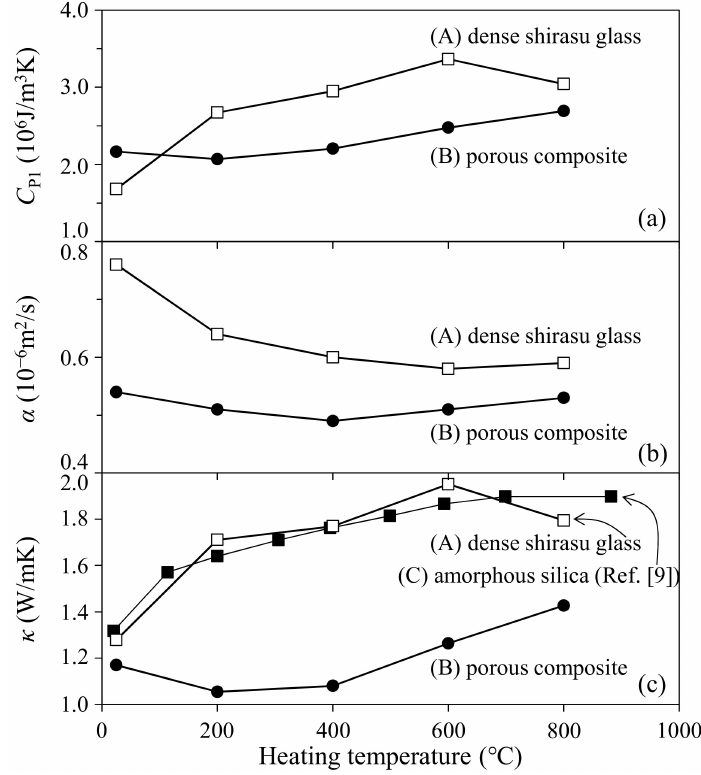
Figure 8. ( a ) Heat capacity; ( b ) thermal diffusibility; and ( c ) thermal conductivity of the monolithic